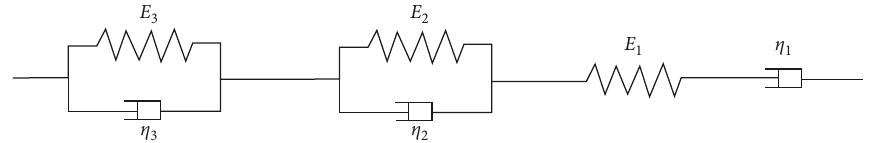
, η , and η are the viscosity coefficients). 0 1 2